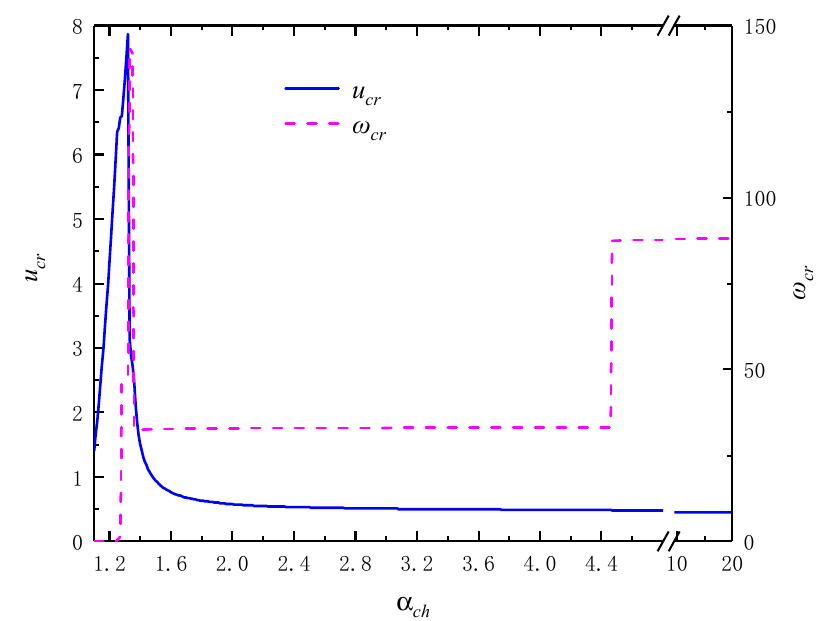
Figure 6. Leaching-tubing-like systems with r ann = 0.50 and ε = 1124.9 ( L = 200 m), theoretical variation of u cr and ω cr with the radial confinement α ch . The results are based on the instability of the first prediction. A zero frequency (i.e., ω cr = 0) indicates divergence.